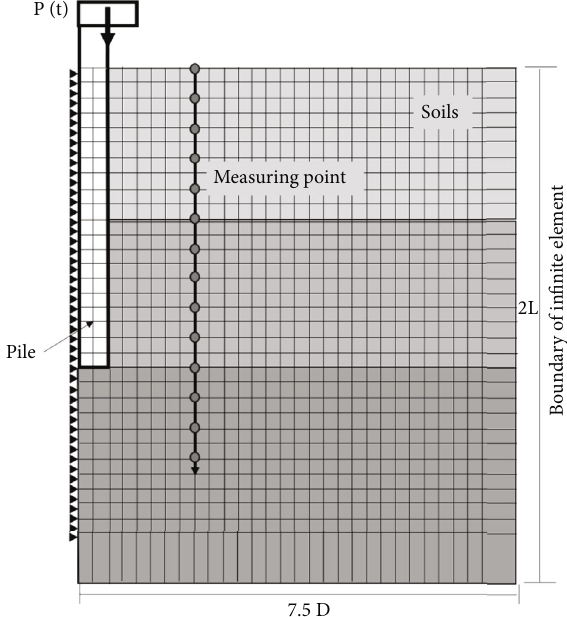
Figure 6: Schematic diagram of the fi nite element mesh for pile foundation inspection by parallel seismic